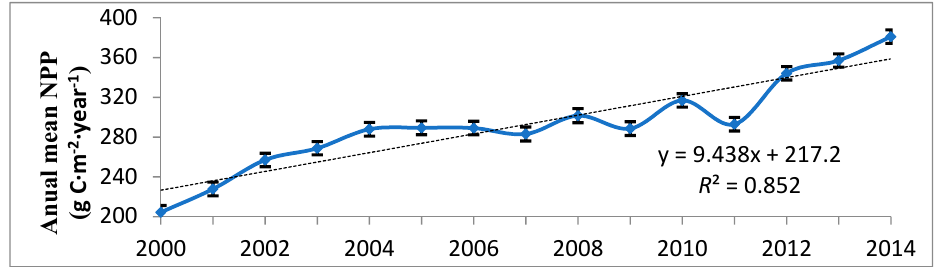
Figure 3. Interannual variations in the annual average NPP in the Jinghe River basin from 2000 to 2014.